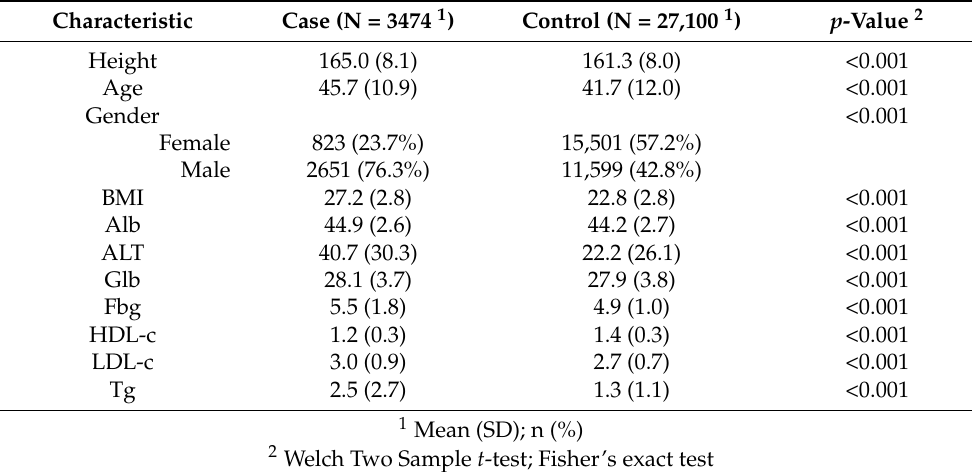
Table 3. Characteristics of study